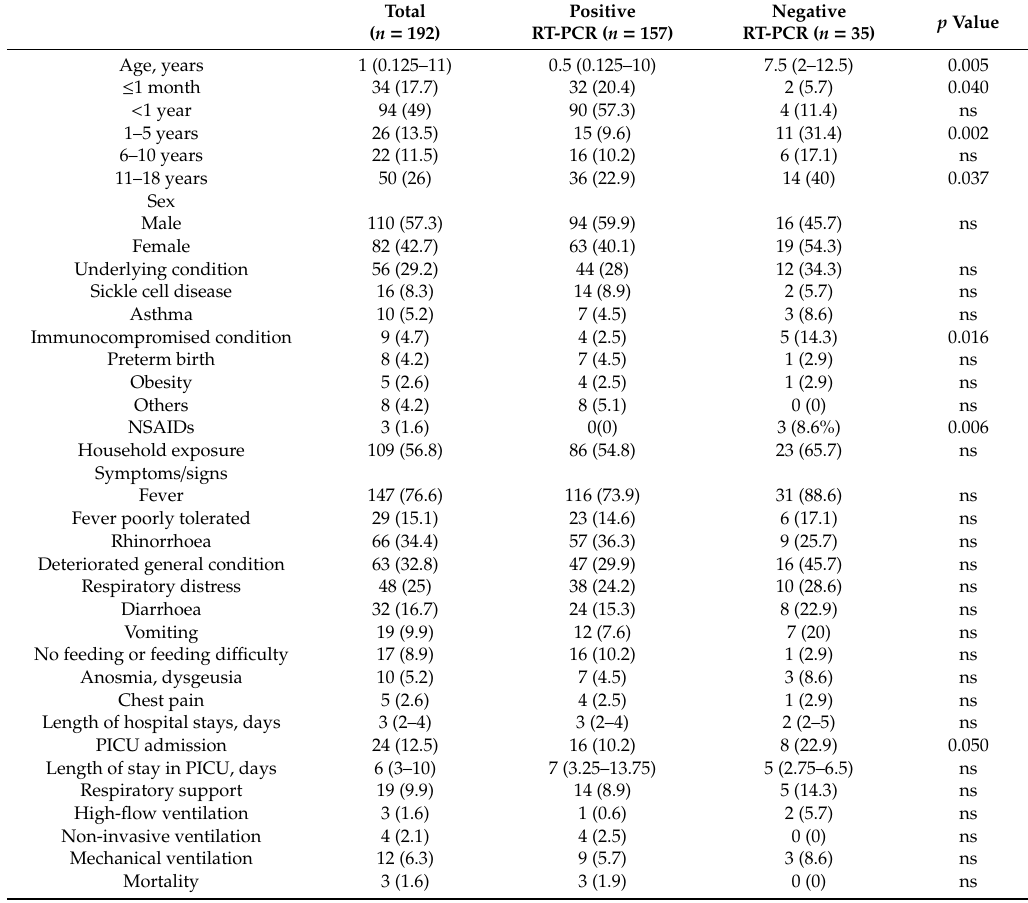
Table 1. General characteristics of hospitalized children depending on positive or negative RT-PCR results for